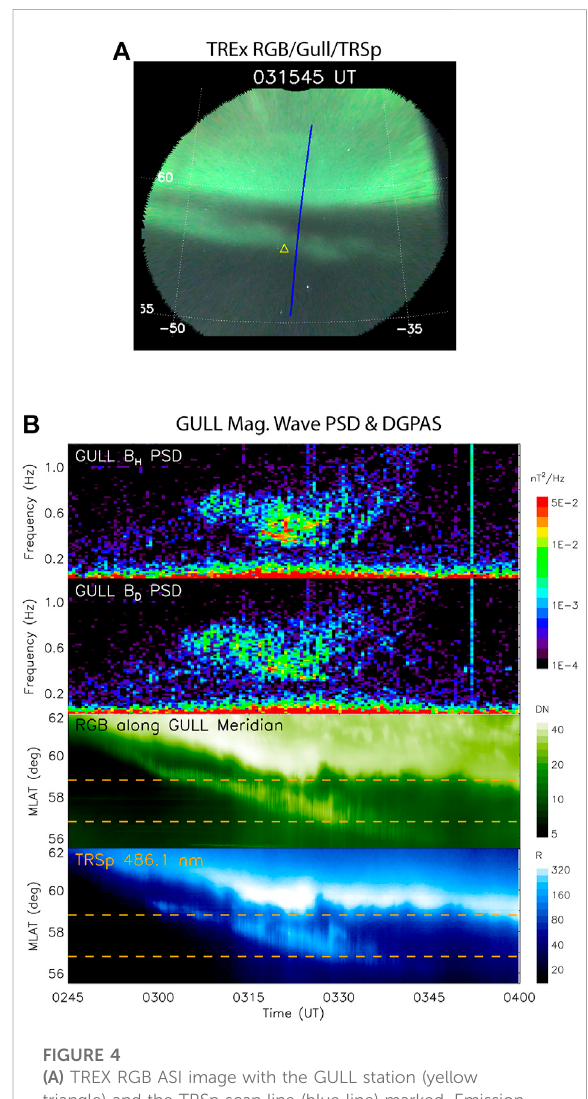
FIGURE 4 (A) TREX RGB ASI image with the GULL station (yellow triangle) and the TRSp scan line (blue line) marked. Emission altitude is 135 km. (B) The top two panels show the PSD spectrogram of the Bh and Bd components from the GULL magnetometer data. The third panel shows the RGB ASI keogram sampled along the GULL magnetic meridian. The bottom panel shows the keogram of 486.1 nm emissions calculated from TRSp observations. Two horizontal dashed lines in the bottom two panels indicate ±1 0 MLAT north and south of the GULL